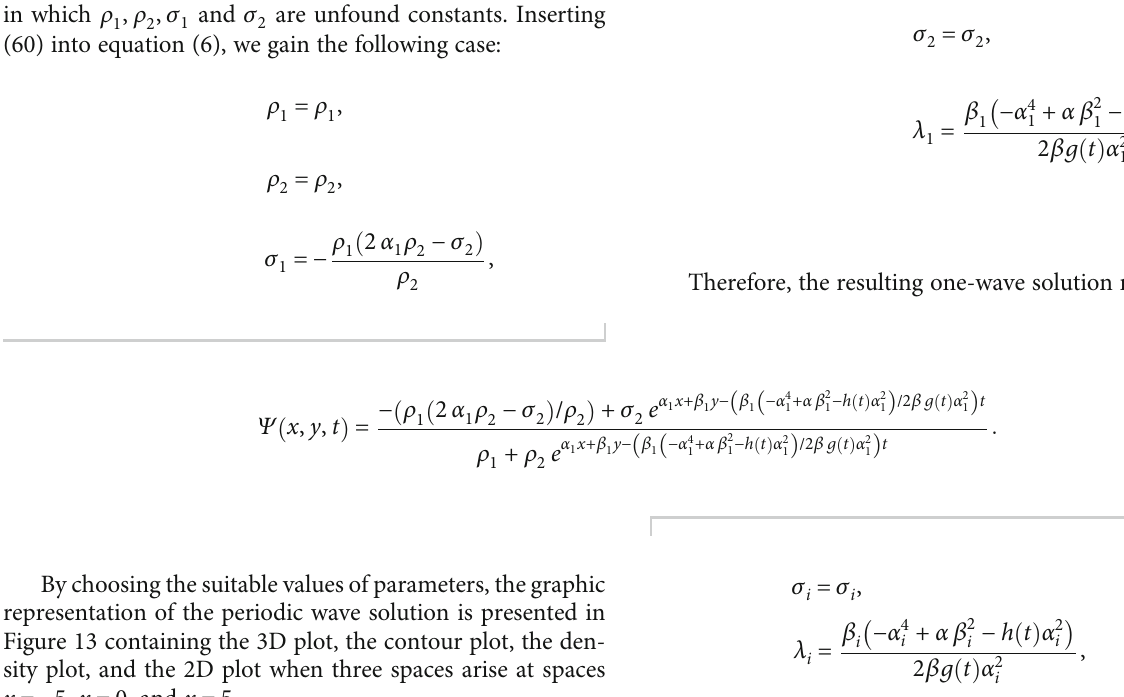
= 1, β = 1 : 5, σ = 2, rho = 2 : 2, ρ = 3, g ð t Þ = sin ð t Þ , h ð t Þ = cos ð t Þ , and y = 1 1 2 1 1 2